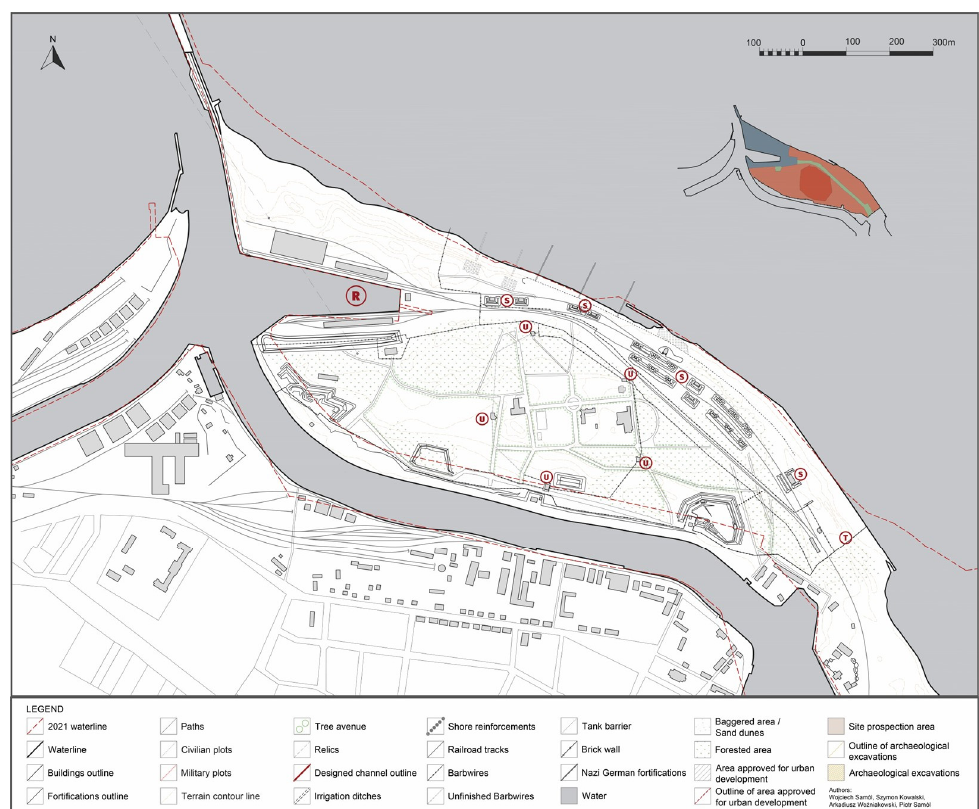
Figure 10. Westerplatte in 1939 as a fortified Polish military transit depot. The top scheme shows three different areas of defence. Blue—port facilities, green—train transit area, red—military area with inner circle perimeter.